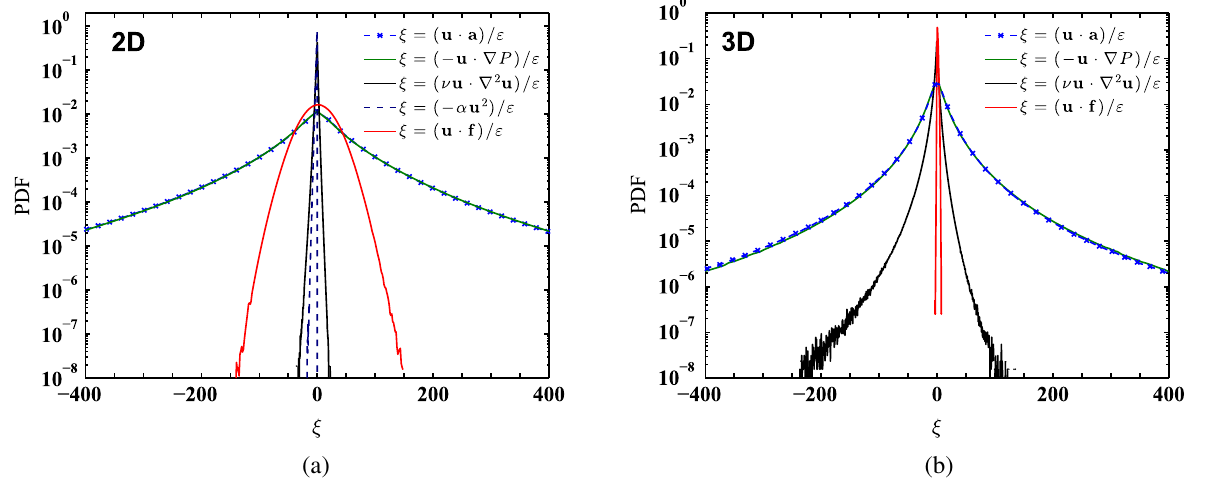
FIG. 1. Probability density functions (PDFs) of the instantaneous power p ¼ u · a and its components in both 2D and 3D turbulence, all nondimensionalized with the turbulence energy flux ε . (a) The PDFs of p= ε , − u · ∇ P= ε , ν u · ∇ 2 u = ε , u · f = ε , and the friction term − α u 2 = ε from direct numerical simulations (DNS) of 2D turbulence at R − u · ∇ P= ε , the viscous dissipation term ν u · ∇ 2 u = ε , and the forcing term u · f = ε from 3D DNS at R magnitudes of the instantaneous power and the contribution from the pressure gradient are much larger than those from the dissipation term and the external